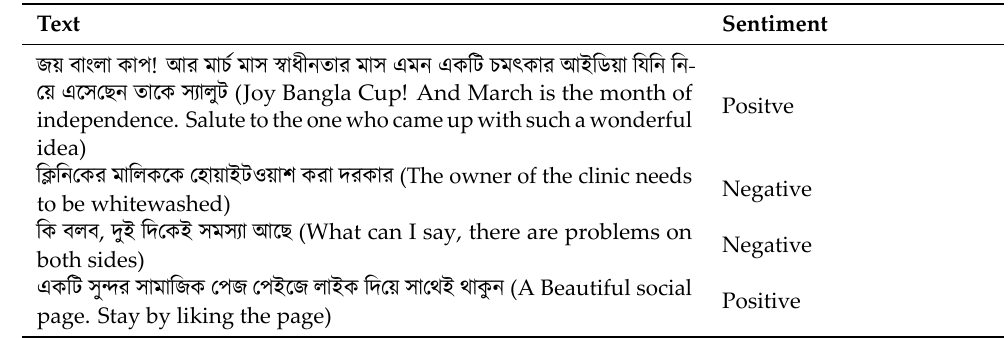
Table 1. Example of collected texts for sentiment